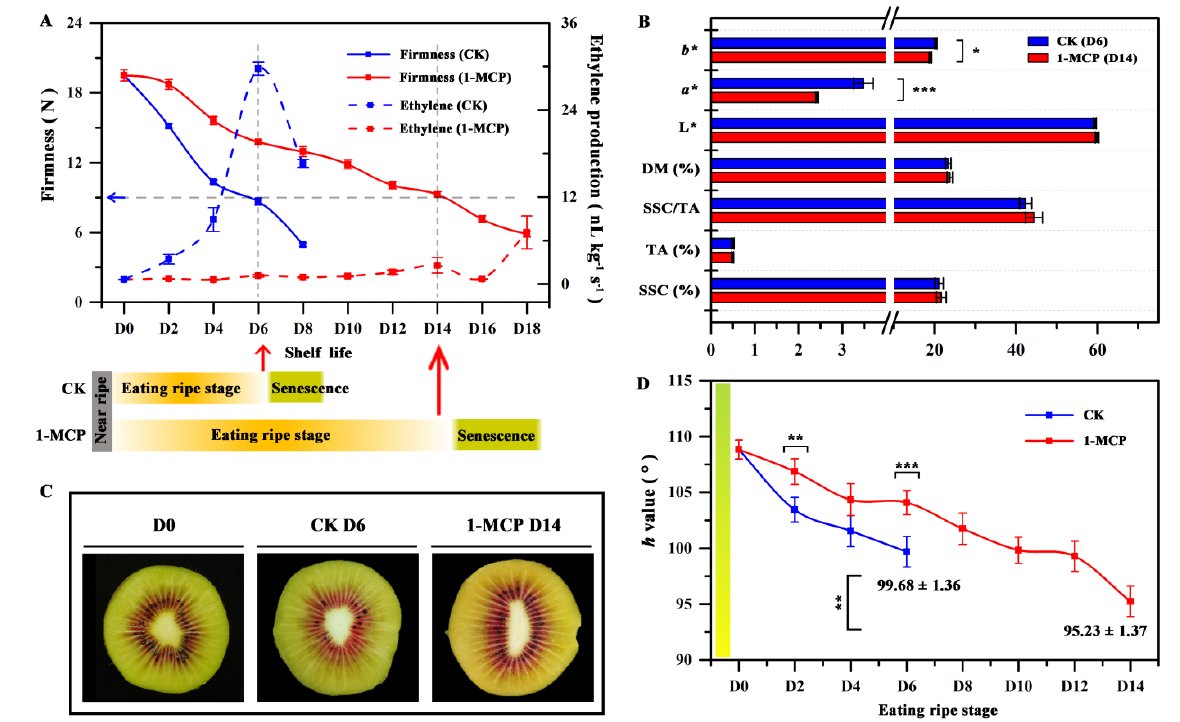
Figure 1. The fruit physiology indicators and flesh color after 1-MCP treatment. ( A ) fruit firmness and ethylene production; ( B ) SSC, TA, DM, and color of kiwifruit after 1-MCP treatment; ( C ) the phenotype of control fruit at D6 and 1-MCP treated fruit at D14; ( D ) h value during the eating ripe stage. Data are mean ± SE ( n = 3). Values with different letters represent significant differences in the same group (1-MCP group or control group) during ripening ( P < 0.05). Asterisk represents a significant difference between the control (CK) and 1-MCP treated fruit (* P < 0.05, ** P < 0.01 and *** P < 0.001).